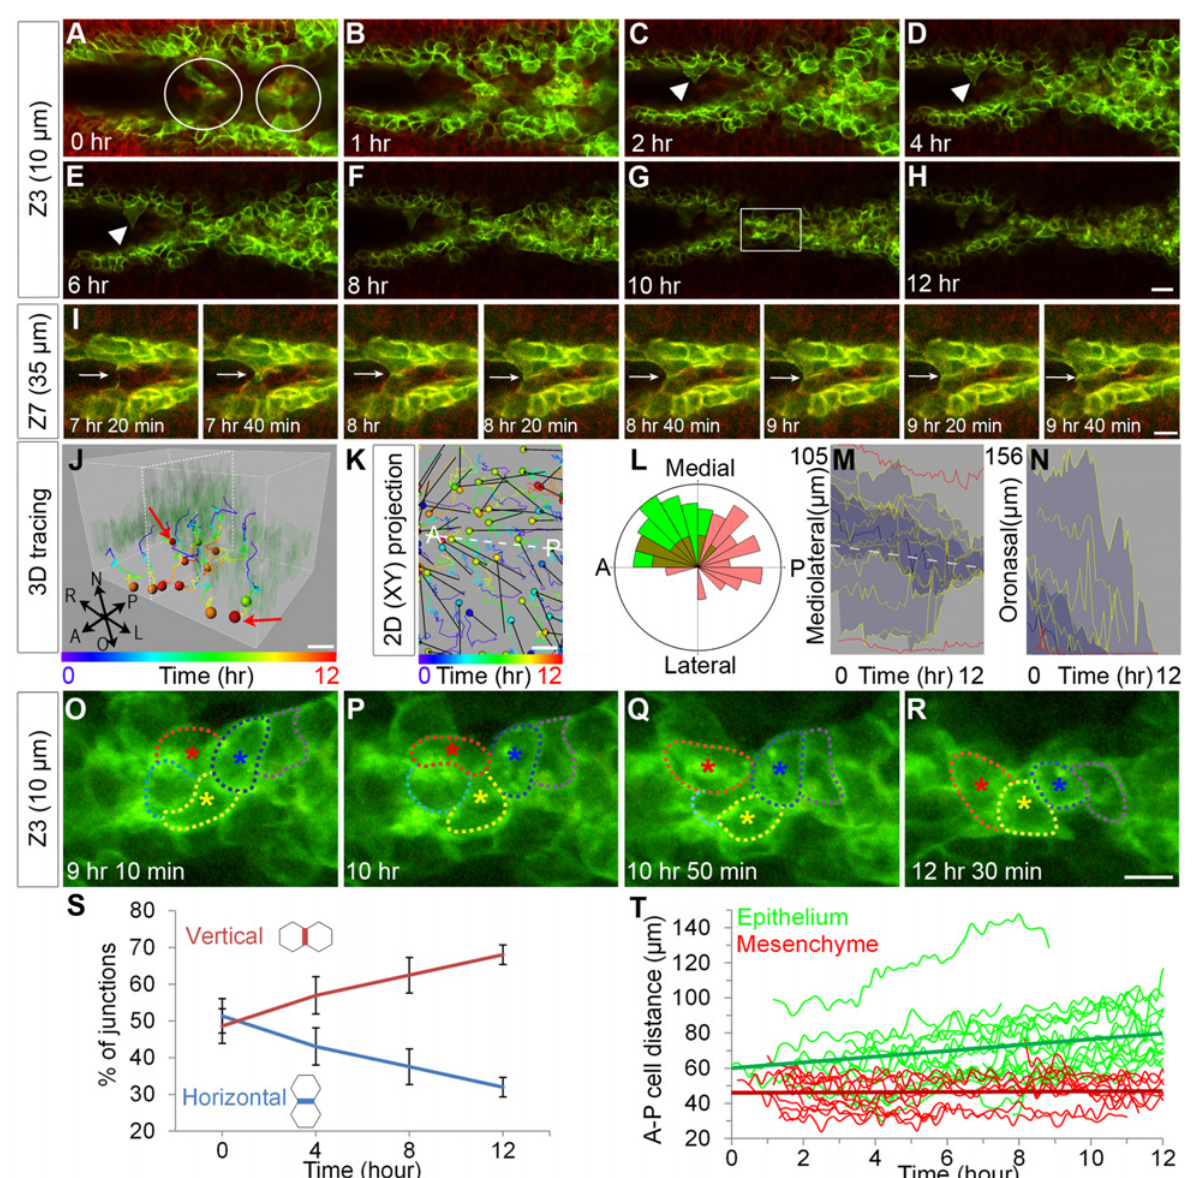
Fig 1. Cellular protrusions and cell intercalation during initiation of palatal fusion. (A – H) Confocal time-lapse imaging of K14-Cre; ROSA26 mTmG/+ palatal explant cultures reveals initial contacts made by cellular protrusions (white arrowhead) from each epithelium that form cellular bridges (white circles in A). Over the 12-hour imaging period, a multicellular epithelium becomes integrated into a single shared MES. Scale bar, 20 μ m. (I) Higher magnification view of deeper optical sections reveals membrane extension and junction formation during palatal adhesion. Scale bar, 10 μ m. (J) 3-D tracking and (K) 2-D tracking of cells in projection from all optical sections shows that epithelial cells in the MES converge toward the midline and displace toward the oral surface. The colors of the tracks indicate time; the colors of spheres indicate the last time points at which cells could be tracked. Dashed white lines in J and K indicate the plane of the MES. In K, displacement is shown with black arrows. Scale bar, 10 μ m. A: anterior, P: posterior. (L) Rose diagram indicating angle of displacement for tracked cells (green, epithelium; red, mesenchyme) (M) Vantage plot of mediolateral position over time indicates that cells are converging to the midline. The approximate position of the MES midline is shown with a white dashed line. (N) Vantage plot of oronasal position over time indicates oral displacement of MES cells. In M, N the yellow lines are individual cell positions, the thick blue line is the median of the cell movements, the dark blue area is a range between the lower quartile and upper quartile, and light blue indicates the maximum range for 30 cells. Red lines are mediolateral (M) and oronasal (N) positions of lateral epithelial reference cells. (O – R) High magnification of time-lapse imaging in the region indicated in (G) outlines cells engaged in neighbor exchange. Scale bar, 10 μ m. (S) Relative abundance of horizontal (-30°-30° to midline) and vertical (60° – 120° to midline) junctions over the time course of palate fusion. Lines represent percentage of each junction type over n = 7 sections (relative mean ± SEM) (T) Distance between neighboring epithelial cells along the medial edge (green) or mesenchymal cells neighboring parallel to the medial edge (red). Linear best fit trend lines for the average distance are shown by straight green and red lines. Please see S1 Data for raw data.